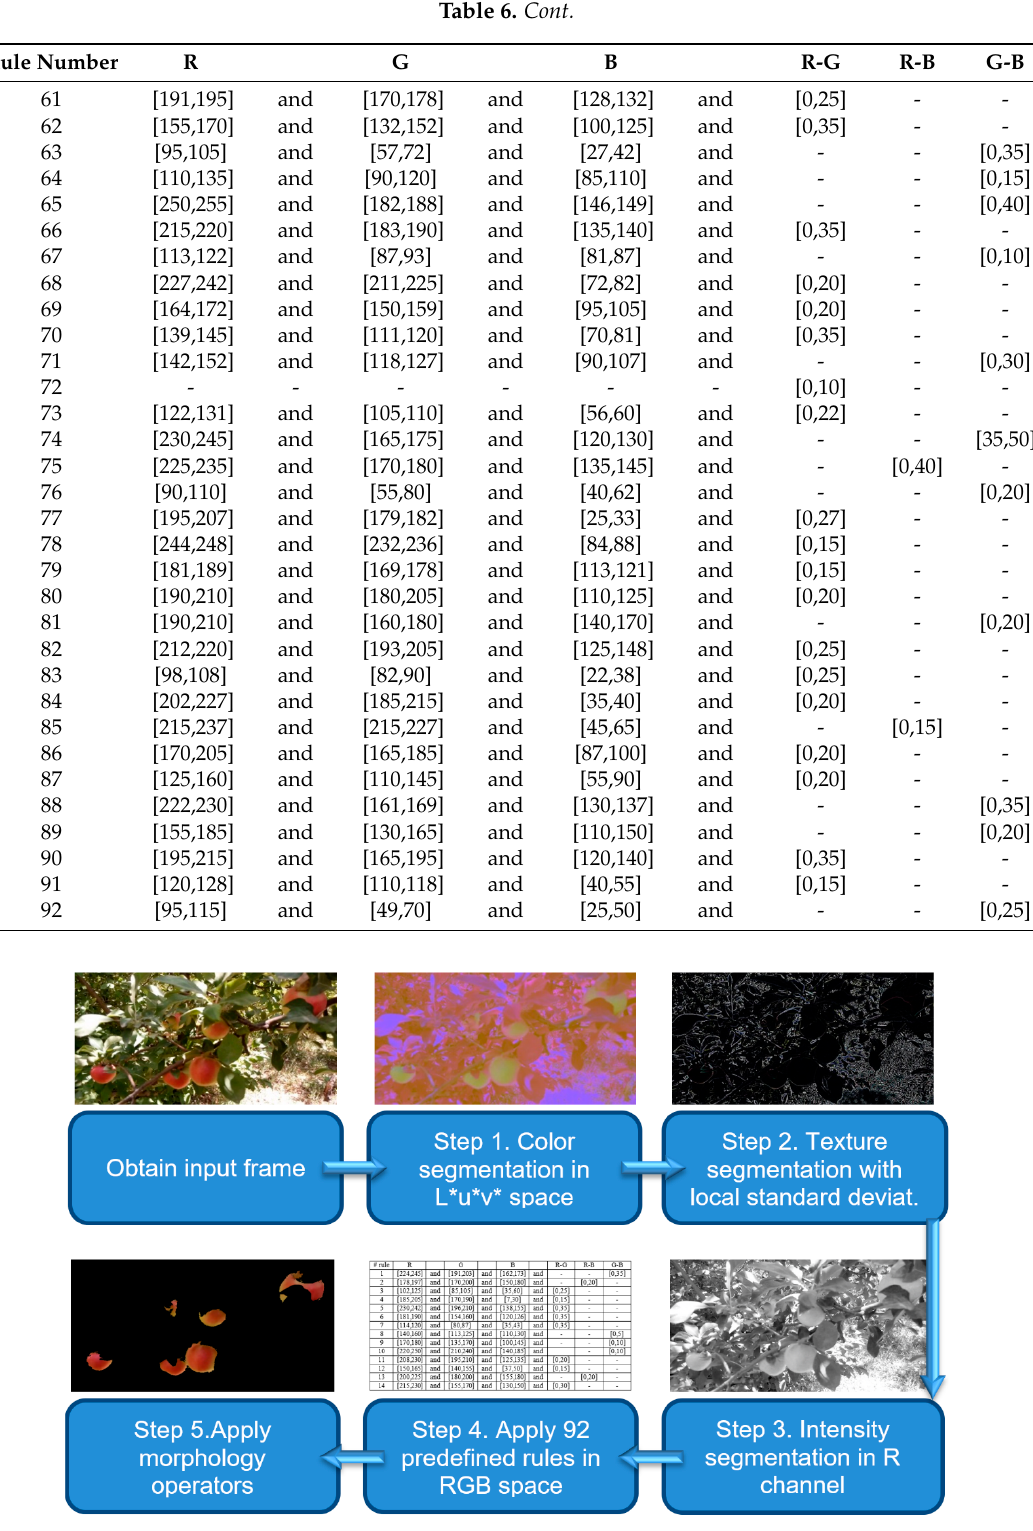
Figure 9. Flowchart of the proposed apple segmentation algorithm.